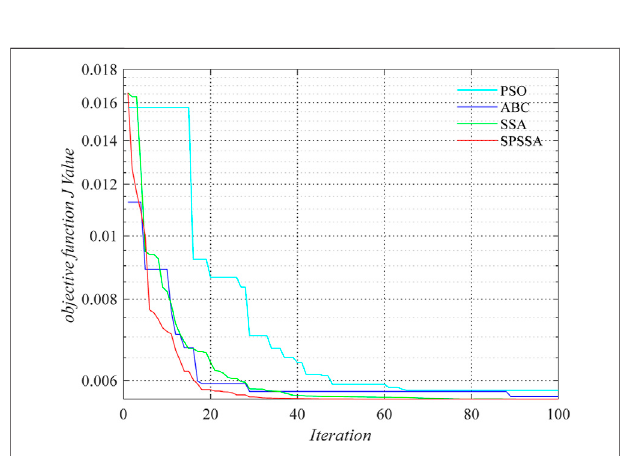
FIGURE 5 | The convergence curve of a memristive chaotic